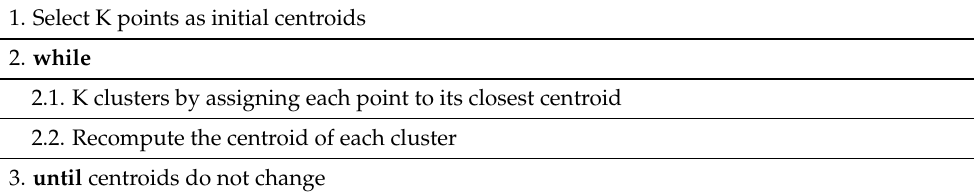
Table 8. Basic k-means algorithm.